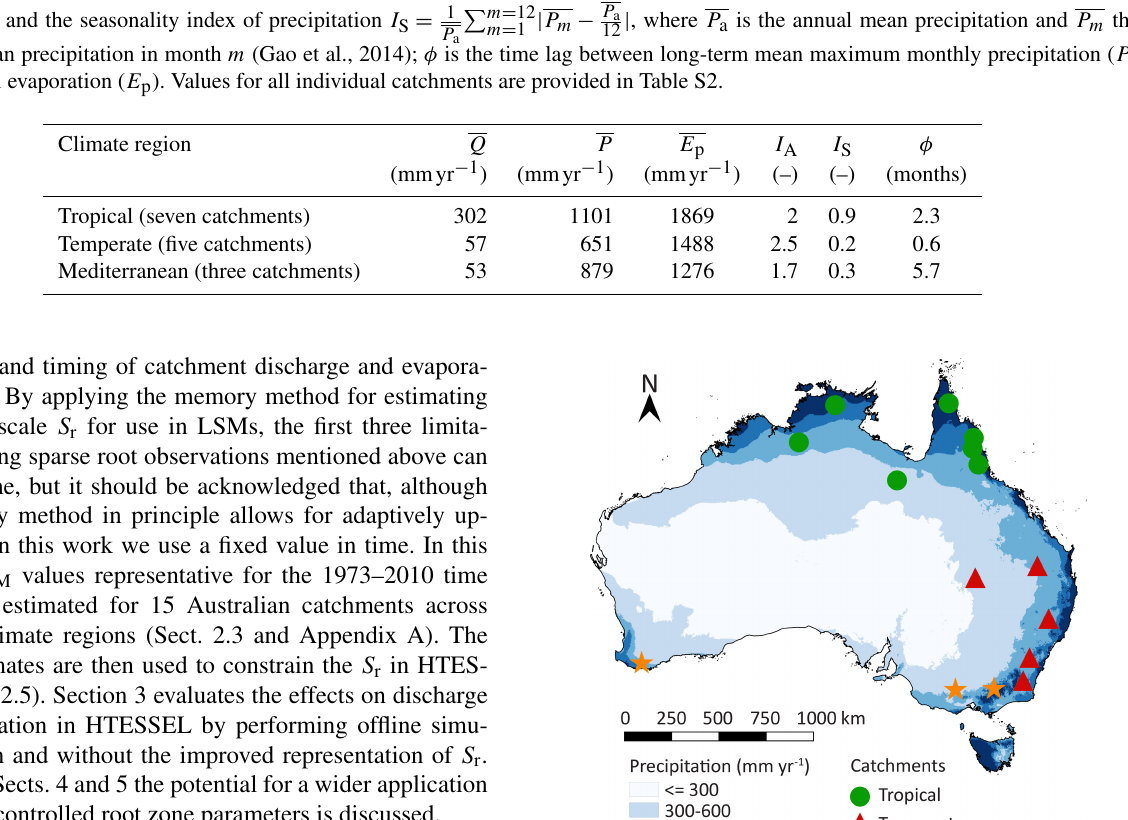
(cid:80) m = 12 | P m − P a | , where P a is the annual mean precipitation and P m the m = 1 12 P a